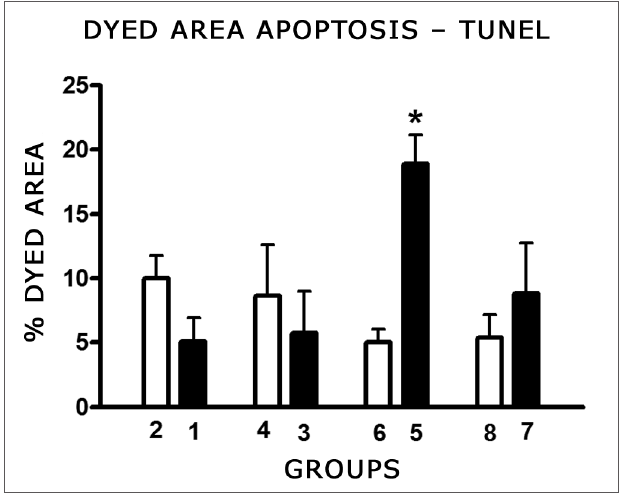
Figure 8. Graph showing the mean fraction ± mean standard error (MED ± EPM) of the colored area (TUNEL positive) in the cochlea basal turn of the animals from the different groups. The asterisk represents statistical significance. T-test: * p = 0.0013 (Group 5 - CDDP 16 D3 DPEAOAE x Group 6 -